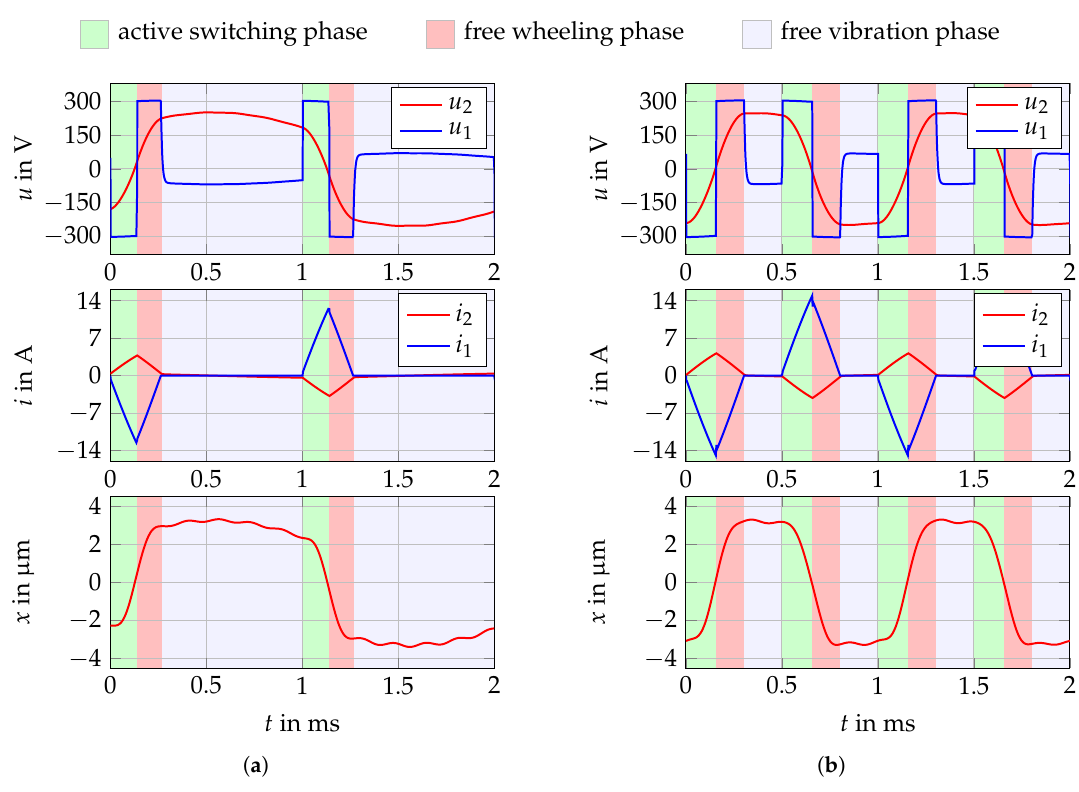
Figure 10. Results of the simulation in steady-state for different excitation frequencies. ( a ) excitation with f = 500Hz; ( b ) excitation with f =